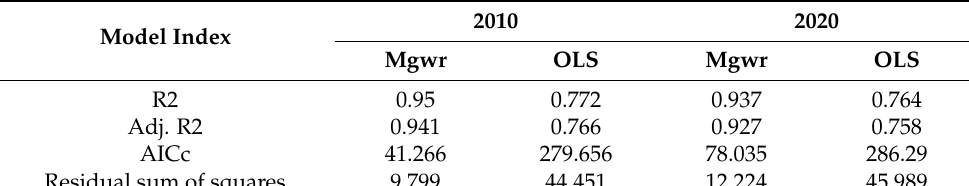
Table 4. Parameter comparison of model running results.